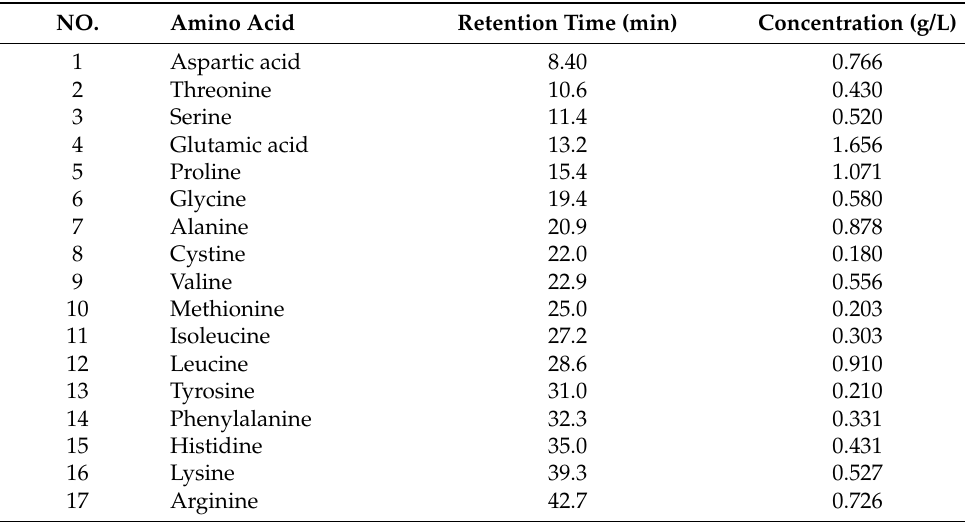
Table 2. Total amino acid composition of CSW used in the current